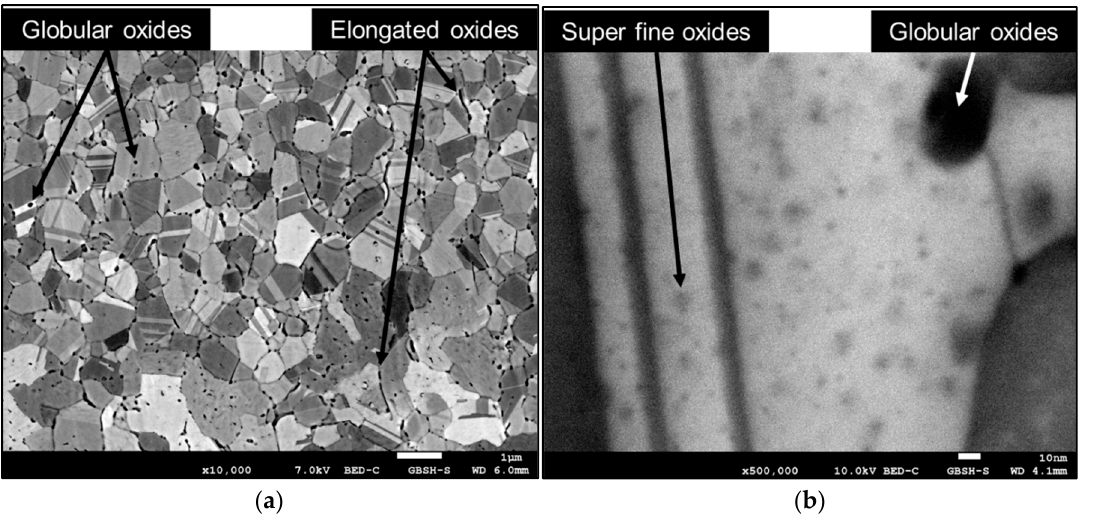
Figure 5. SEM micrograph of the internally oxidised microstructure from the bottom layer of the ribbon (FEG zone after RS): ( a ) overview of a bottom layer; ( b ) detail from the bottom layer with super fine oxide particles in the α Ag grain.